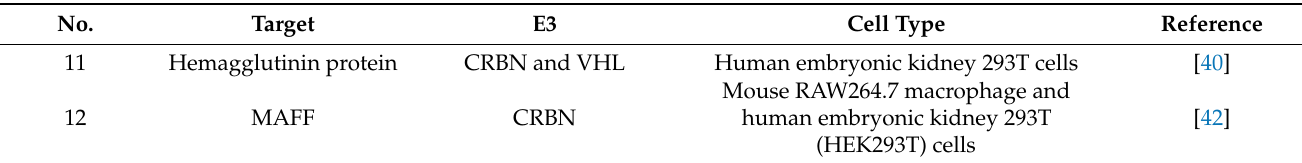
Scheme 12. Synthesis of the lathyrol-derivatized–based PROTAC.